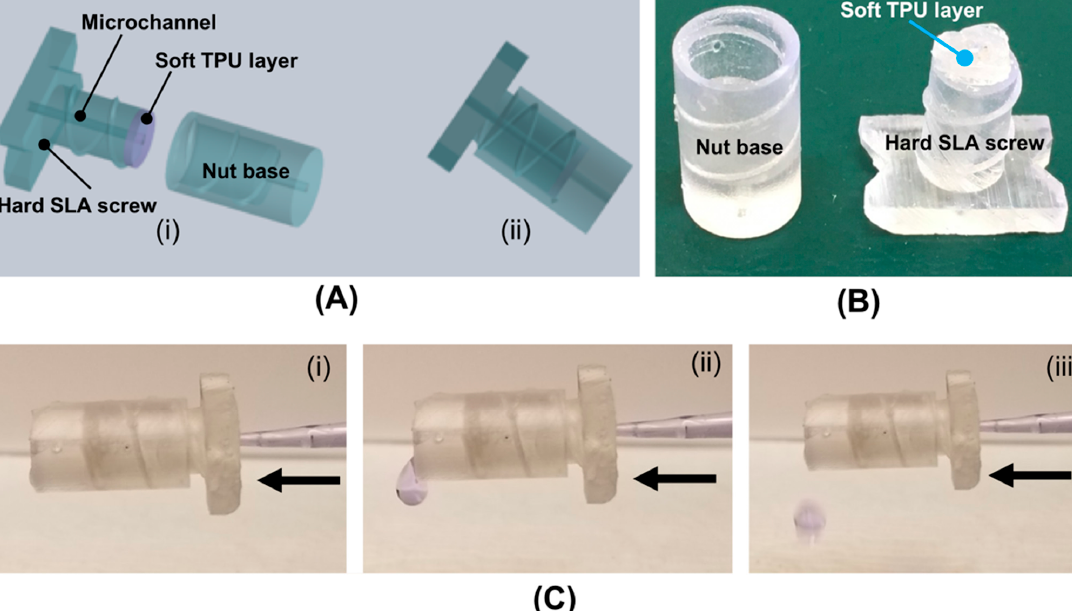
Figure 4. ( A ) Schematic illustration of the hard–soft hybrid microfluidic connector. ( B ) A photo of the 3D-printed nut case and hard–soft screw with a microchannel. ( C ) A sequence of images illustrating the fluid flowing process in the hard–soft hybrid connector.